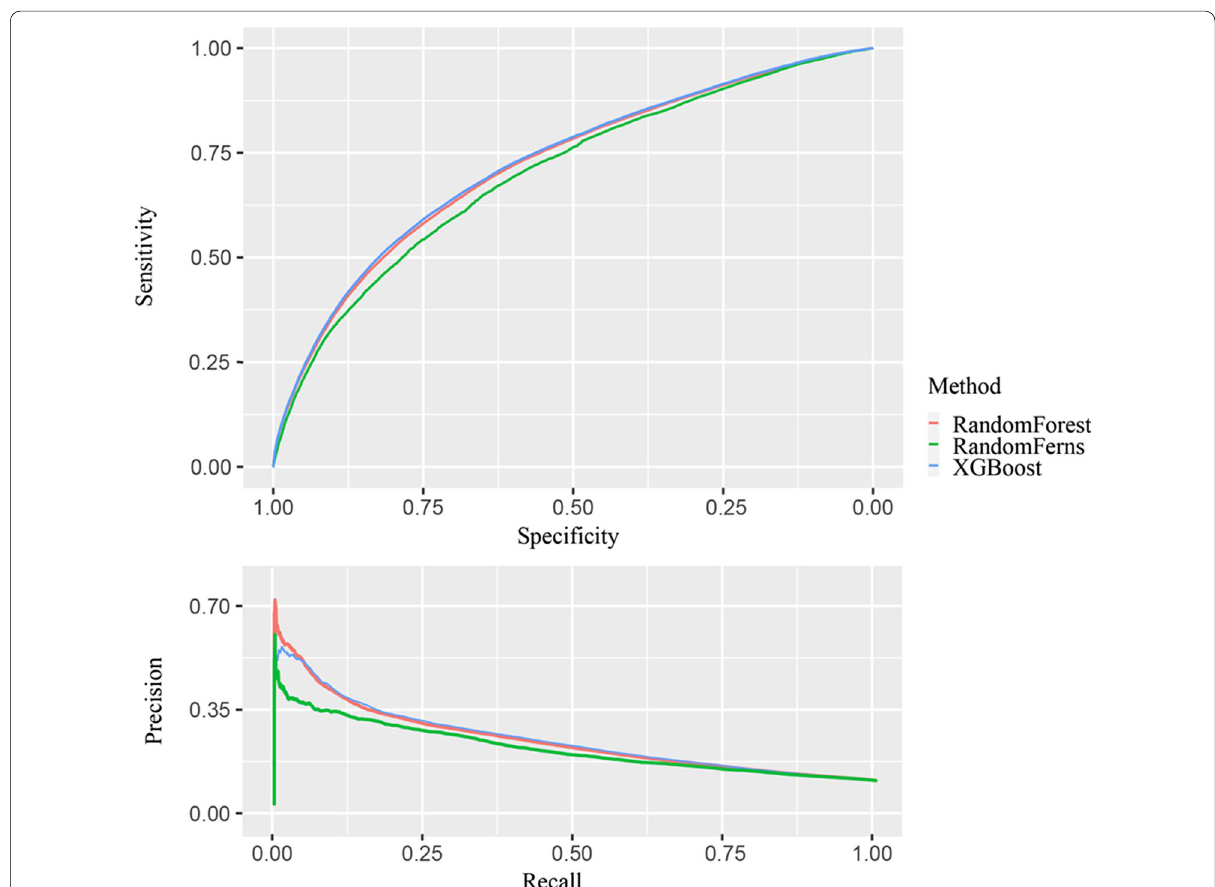
Fig. 3 ROC curve and Precision‑ Recall curve for Random Forest, Random Ferns, and XGBoost